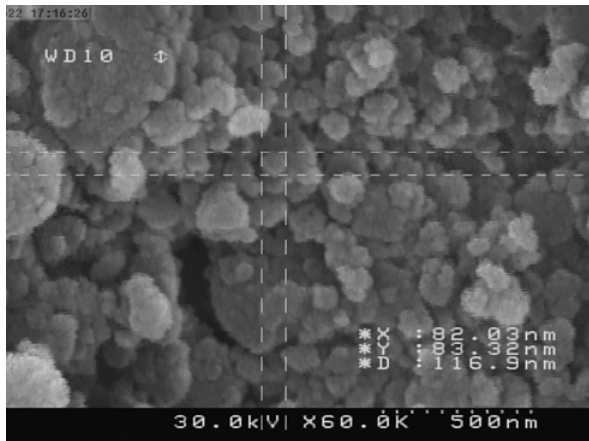
Figure 1: FE-SEM micrograph of nano-basic silica.